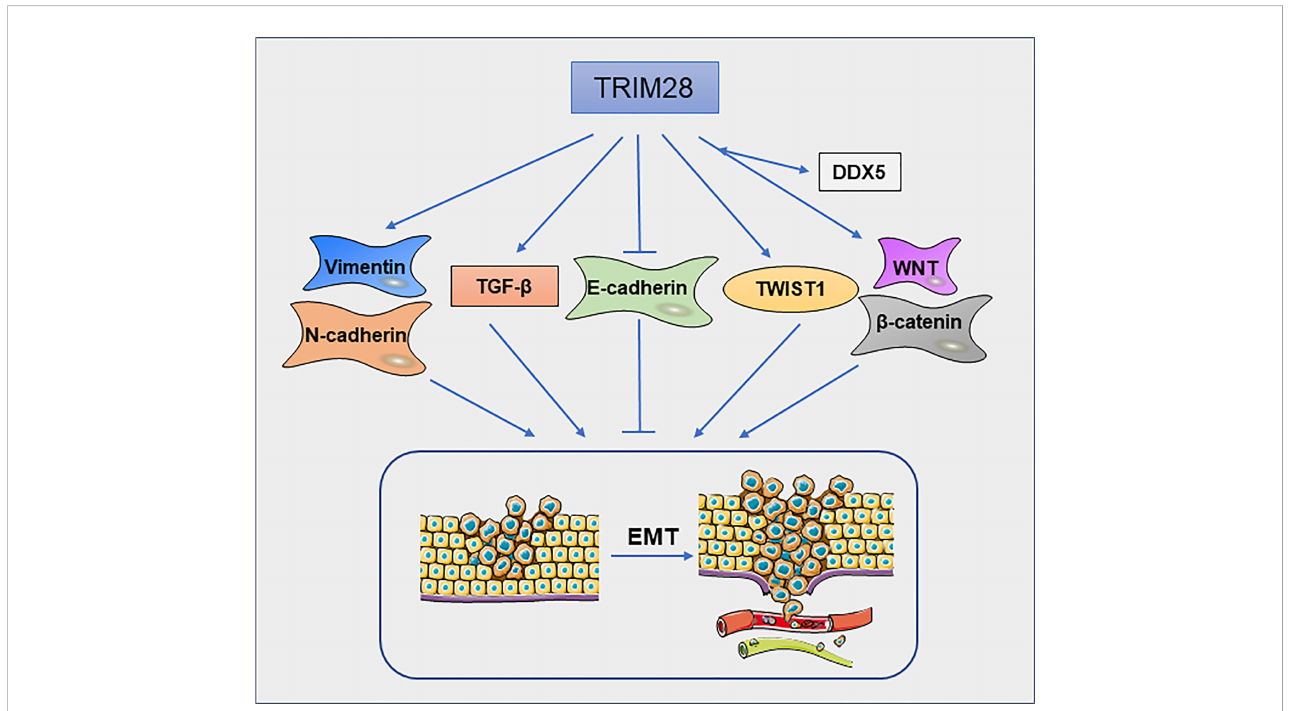
FIGURE 5 TRIM28 regulates epithelial – mesenchymal transition. TRIM28 promotes EMT and leads to enhanced migration and invasion of tumor